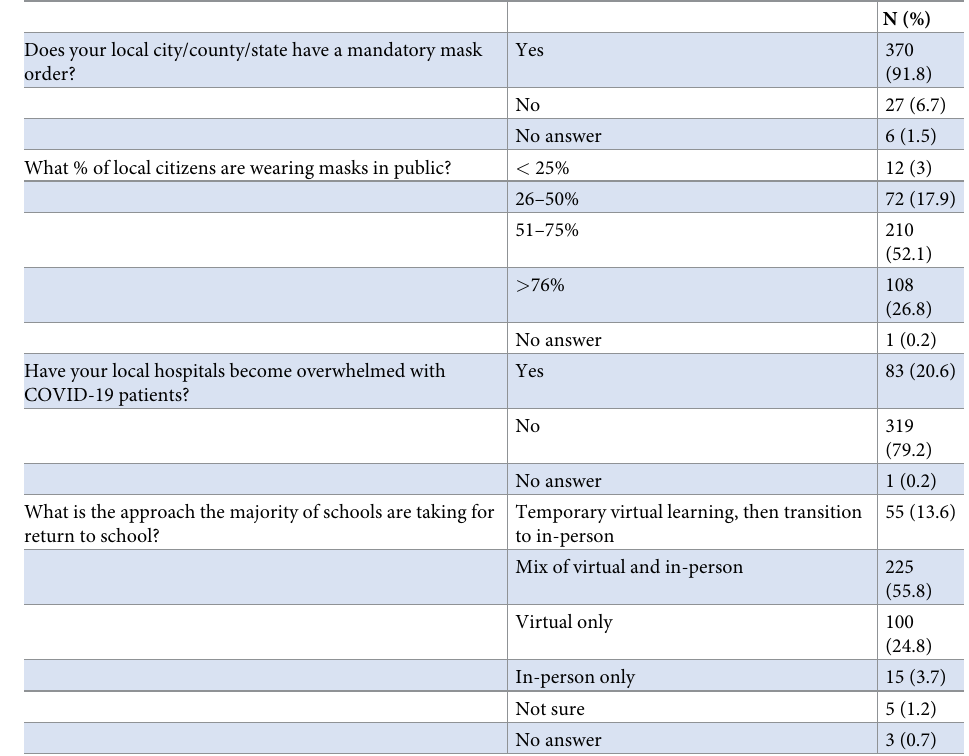
Table 2. Summary of the respondents’ experiences during the pandemic. Does your local city/county/state have a mandatory mask